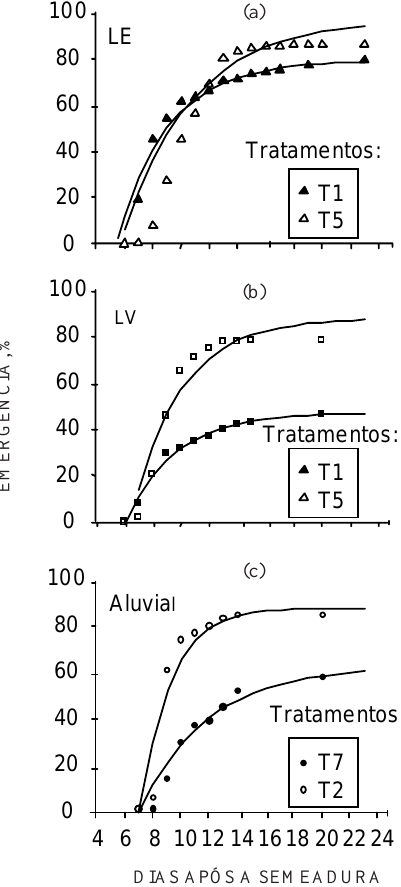
Figura 1. Percentuais de emergência de plântulas de milho, considerando os dias após a semeadura (DAS), para solos LE, LV e Aluvial, ajustados segundo o modelo E= a. [1 - b .exp(- c .DAS)], cujos coeficientes encontram-se no quadro 4, para os tratamentos (Quadros 2 e 3) de pior e melhor